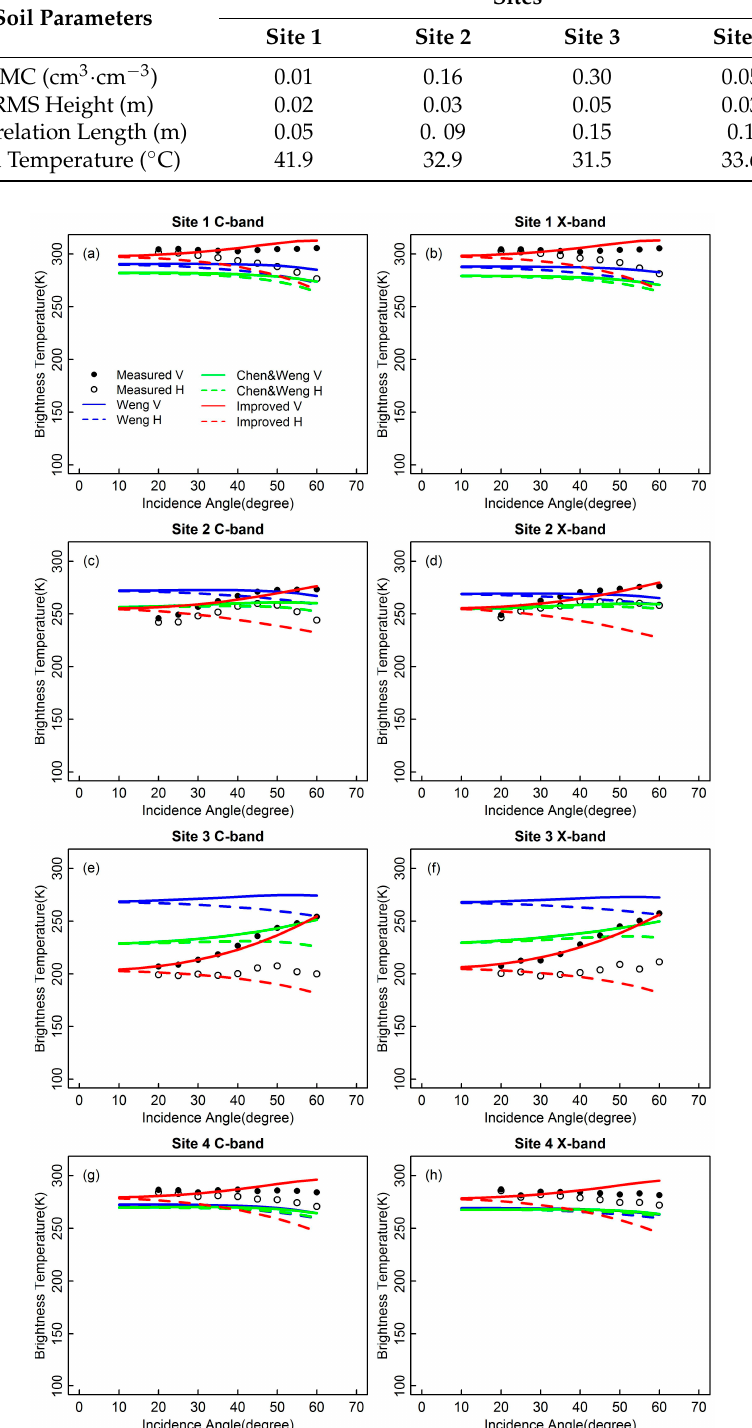
Figure 5. Comparison of brightness temperatures (in K ) between measurements from four sites in Northern China and the calculations by the Weng, Chen and Weng, and parameterized soil surface emissivity models for vertical ( V ) polarization and horizontal ( H ) polarization. The input parameters of soil conditions are listed in Table 3.